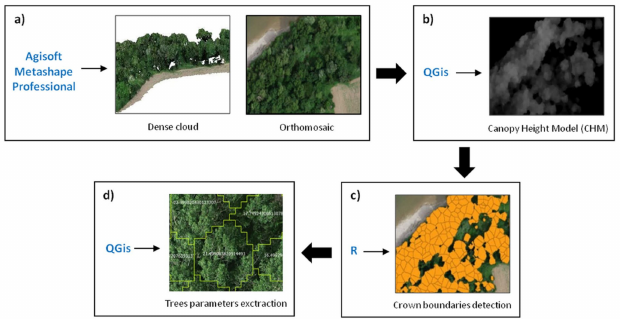
Figure 4. Processing chain of UAV data acquired: dense cloud and orthomosaic ( a ), canopy height model CHM ( b ), trees’ position and crown boundaries ( c ), and main tree parameters ( d ). During the first phase, the Agisoft Metashape Professional software, Edition